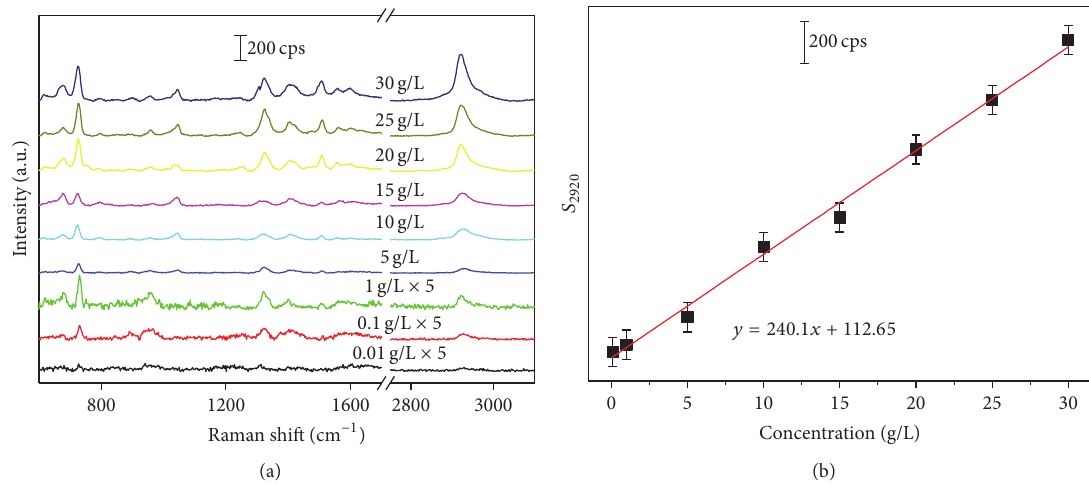
Figure 3: The SERS spectra of SAM solution in various concentrations (a), the quantitative relation curve of the peak intensities centered at ∼ 2920 cm −1 of SAM (b). Each sample was measured for 5 times and the average was